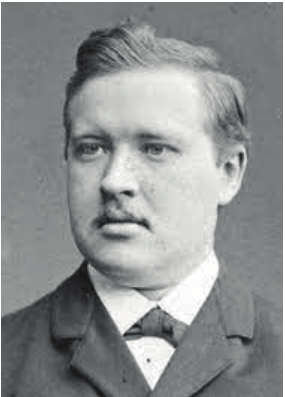
Figure 1. Photo of Svante Arrhenius from 1878, the year when he began his studies at the University in Uppsala. Provided by courtesy of the archives at the Royal Swedish Academy of